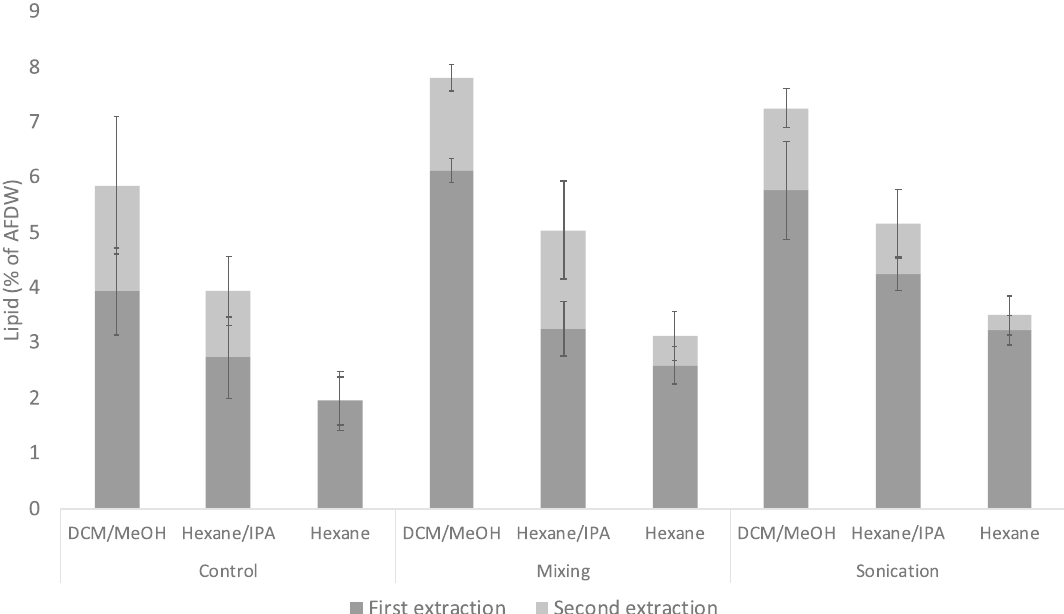
Figure 3. Lipid yields as percent of AFDW (Ash-free dry weight) from Odontella aurita using three solvent systems; dichloromethane/methanol (2:1 v/v) (DCM/MeOH), hexane/isopropanol (2:1 v/v) (Hexane/IPA) and hexane; and three cell disruption treatments; no treatment (control), mixing at 1000 RPM for 60 min (mixing) and sonication at 20 kHz for 10 min (sonication). Two consecutive extractions were performed, data shown is the arithmetic mean of each extraction, n = 5. The error bars represent the standard deviation of the mean for the first extraction (bottom bar) and for the total yield (top